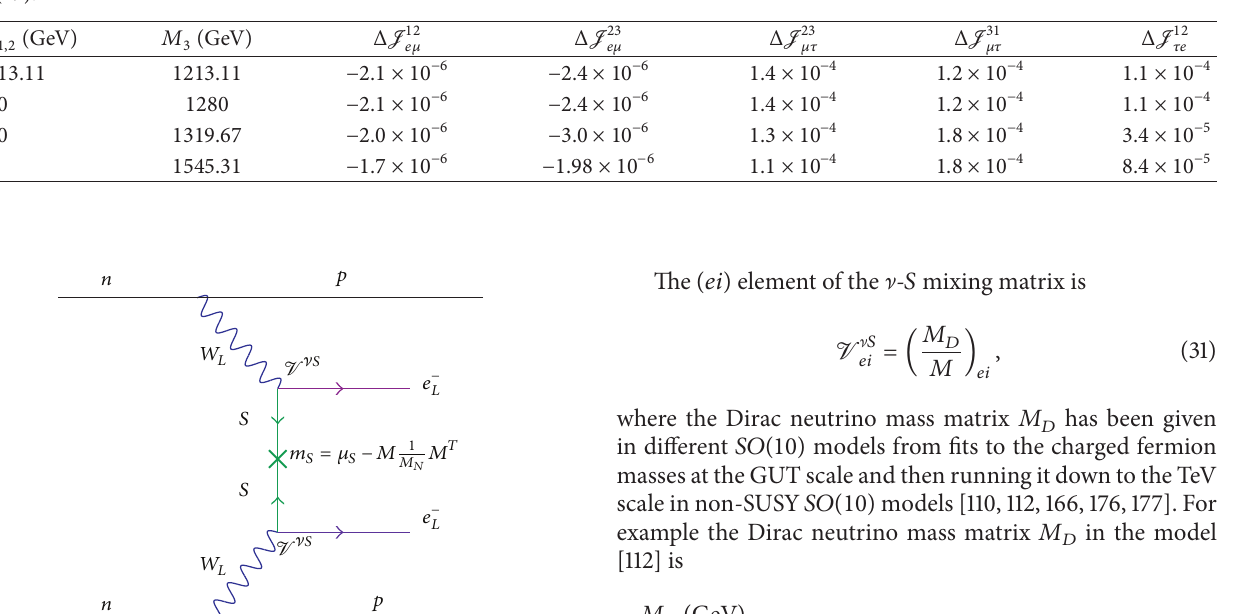
Table 3: Allowed deviations of the rephasing invariant matrix 𝐽 in (29).